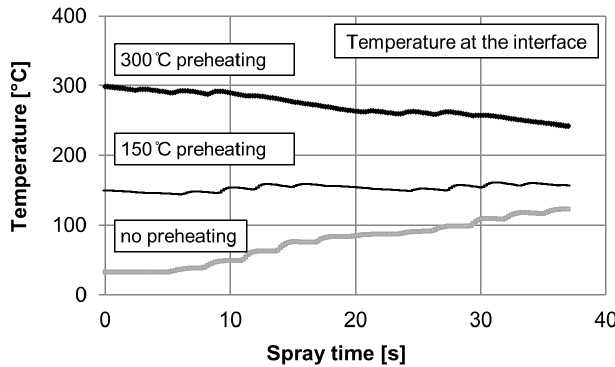
Figure 7. Evolution of the temperature at the interface during spraying depending on the substrate preheating temperature.